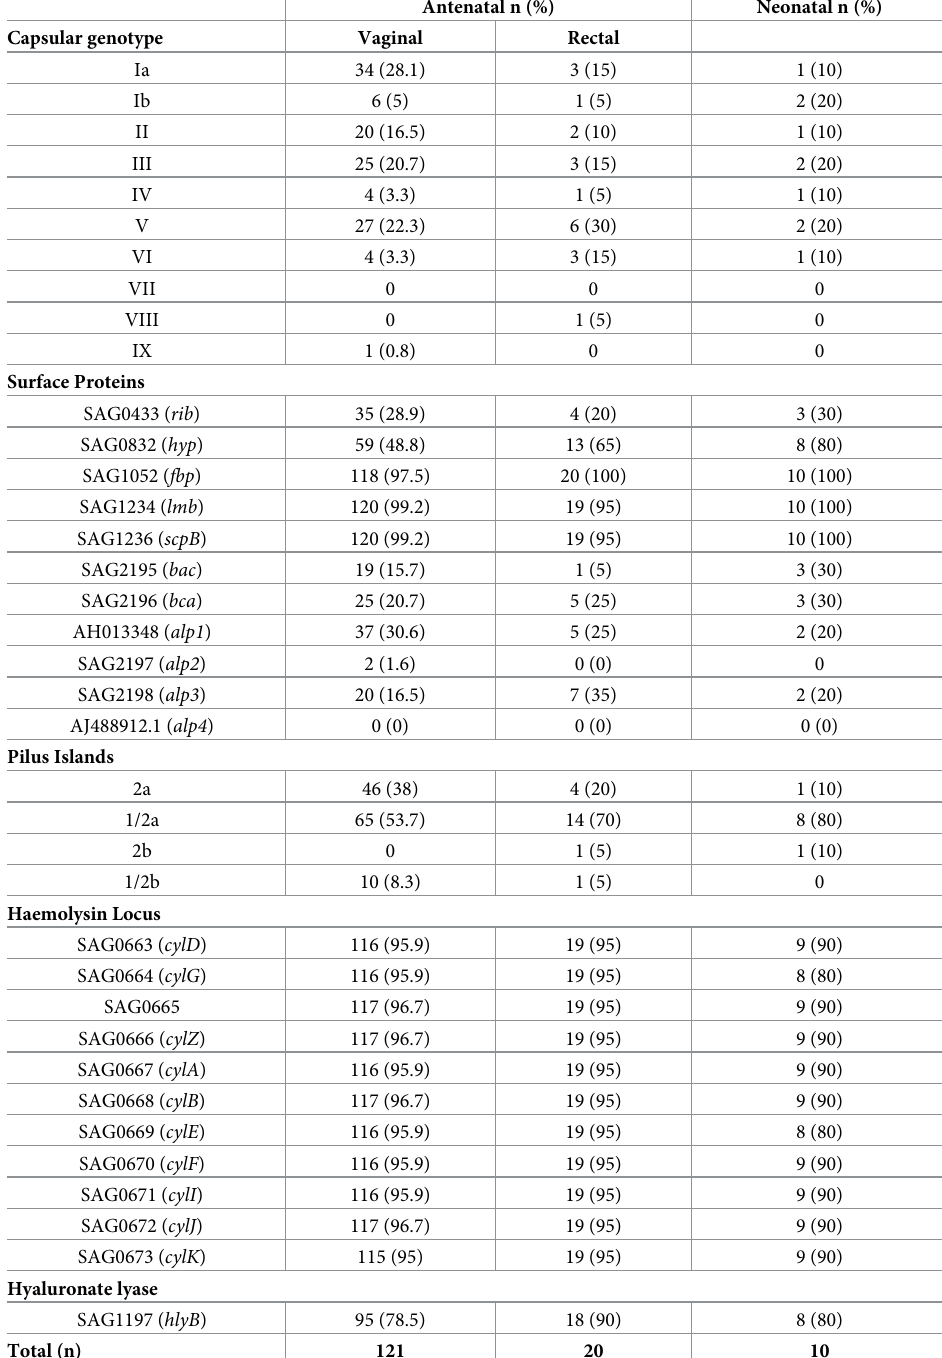
Table 1. Summary of the presence of virulence genes including the capsule, surface proteins, pilus islands, haemo- lysin and hyaluronate lyase within the antenatal carriage and neonatal invasive disease isolates collected from Western